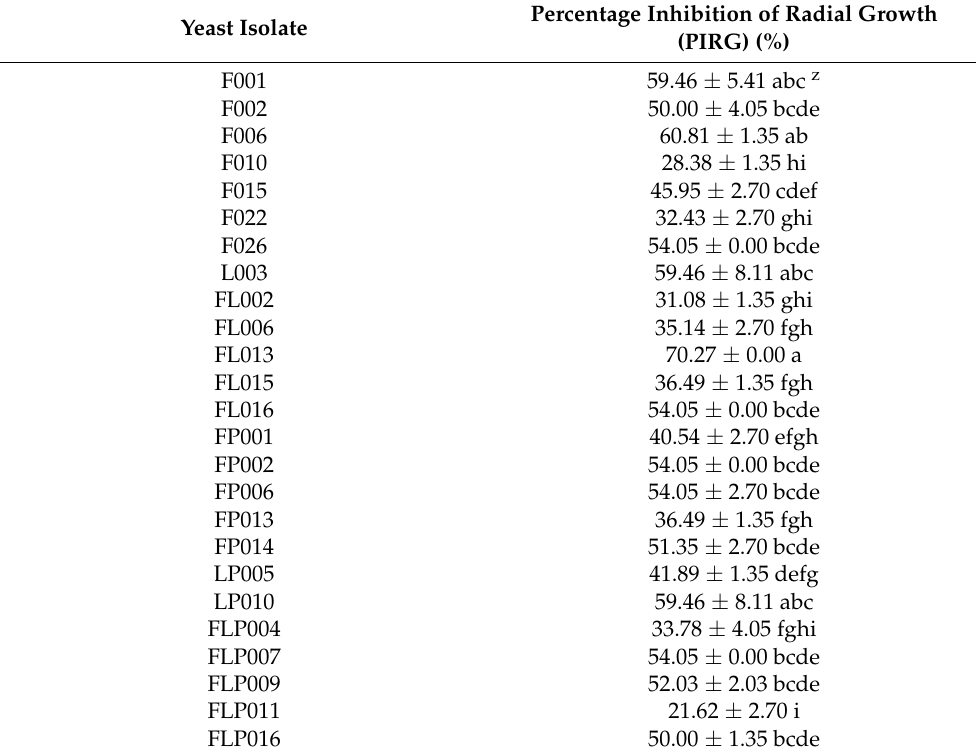
Table 1. Effects of antagonist yeast isolates on radial growth of C. gloeosporioides in dual culture assay after seven days incubation at 28 ± 2 ◦ C.